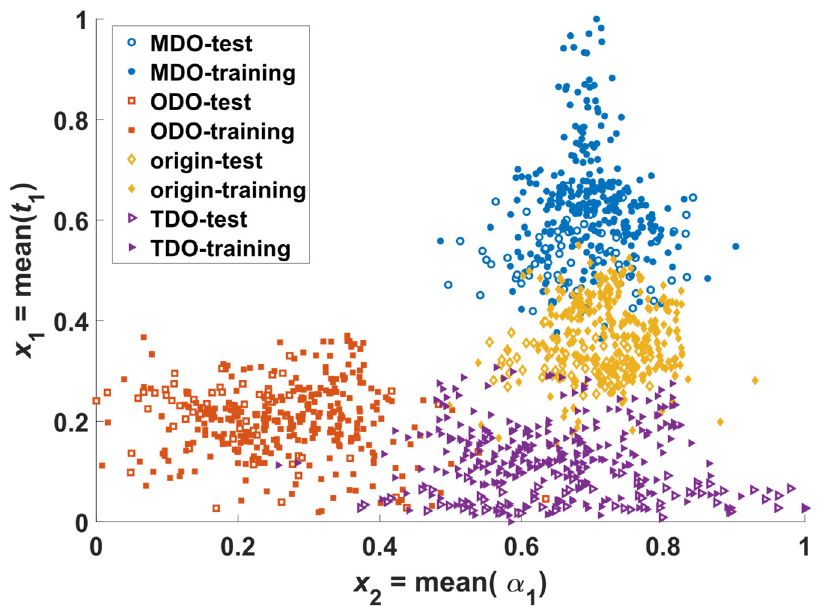
Figure 6. Scatter plot of training and test set data.